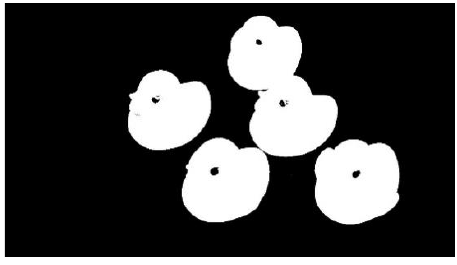
Figure 8. Binarization result of gray image M (cid:48)